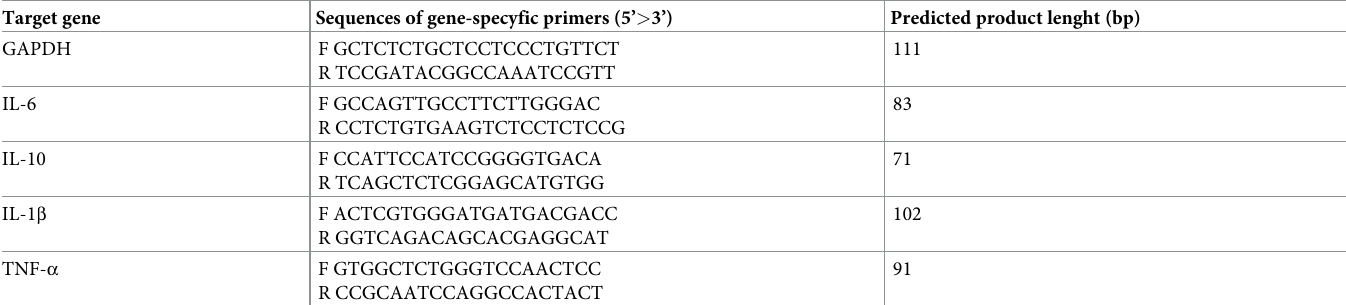
Table 4. Sequences of gene specific primers used in Real Time PCR (F-forward, R-reverse). Target